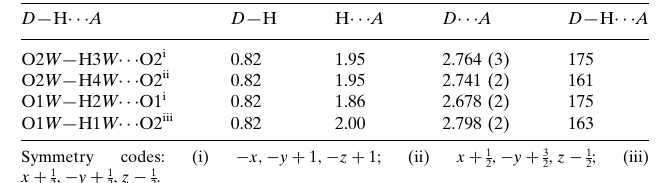
Hydrogen-bond geometry (A˚ , (cid:2)